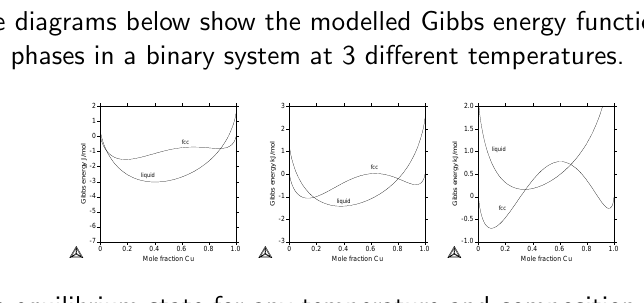
The equilibrium state for any temperature and composition is the lowest Gibbs